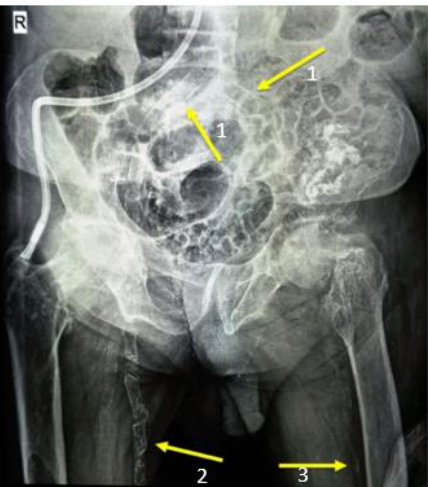
Figure 5. Signs of hypercalcemia in a 55 year old woman with secondary hyperparathyroidism. 1. Calcification of the common iliac arteries; 2. calcification of the right femoral artery; 3. subperiosteal resorption of the left femur.